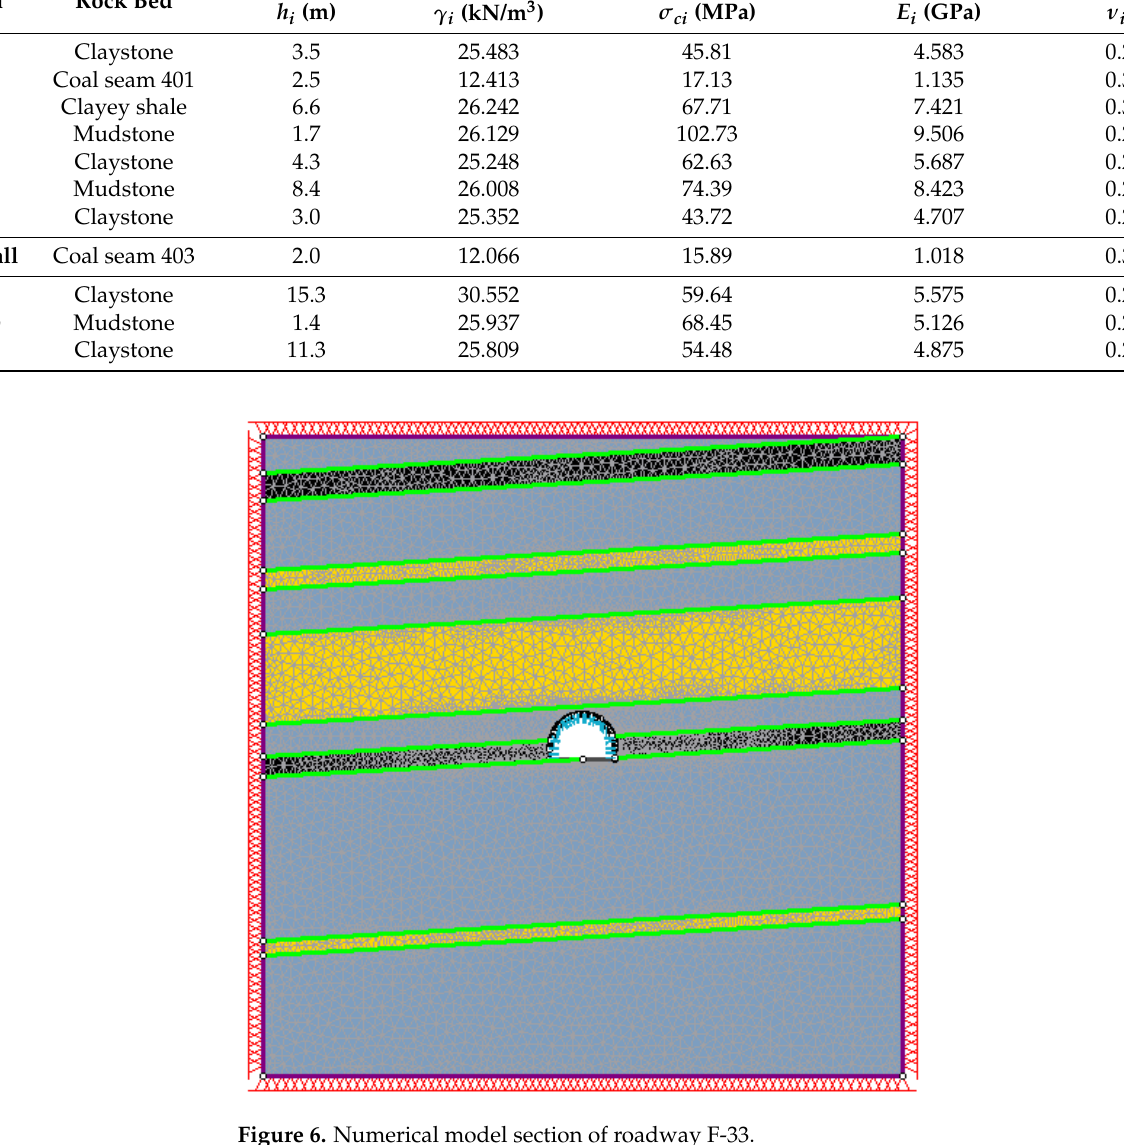
Figure 6. Numerical model section of roadway F-33.